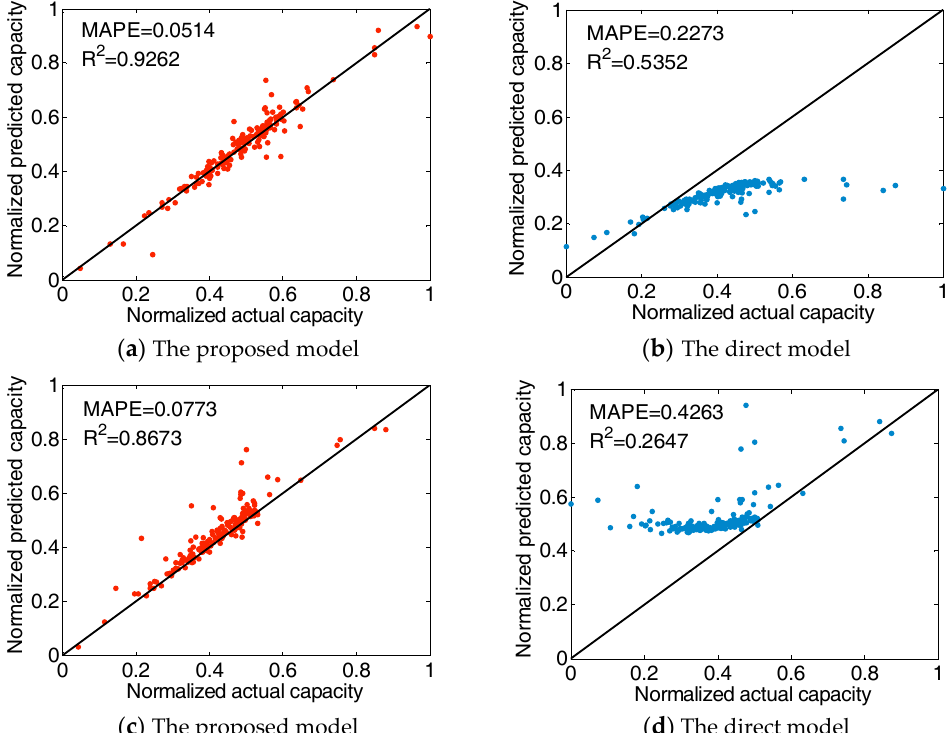
Figure 9. The comparison results for the proposed bootstrap-SVR model and direct model ( a , b ) Using the samples from the “small” group for training ( c , d ) Using the samples from the “large” group for training.